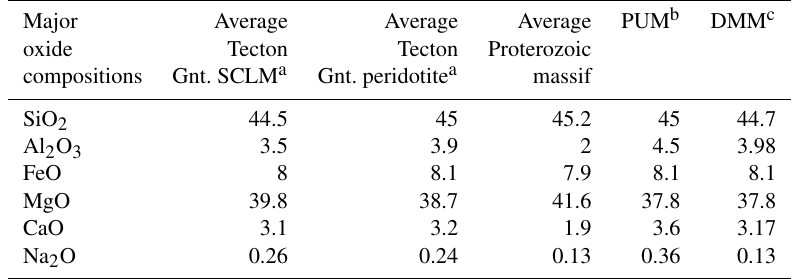
Table 1. Mineralogical composition for the lithospheric and sublithospheric